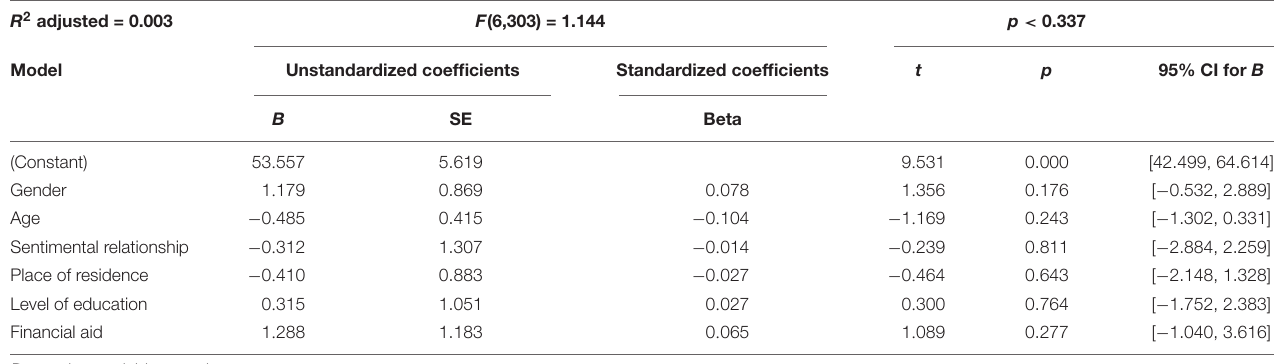
TABLE 4 | Linear regression analysis of the demographic determinants of adolescents’ “practices” toward COVID-19. R 2 adjusted = 0.003 F (6,303) = 1.144